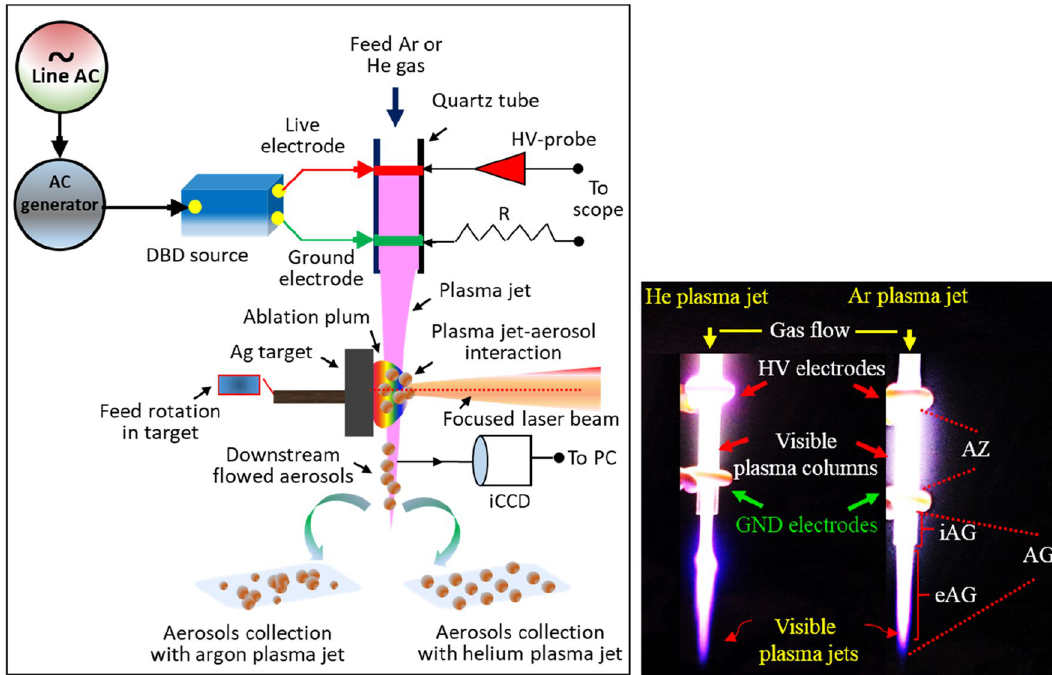
Figure 1. Experimental sketch showing a DBD plasma source, laser ablation process, post-processing & deposition of nanoparticle aerosols with the outflowing plasma jet, the HV-probe to measure the electrical signals, and iCCD to capture discharge optical images. The insets shown are two digital photographs, illustrating the physical appearance of various regions of argon and helium plasmas; the active zone (AZ) between the electrodes, and the afterglow (AG) region, starts just behind the grounded electrode and is further subdivided as the internal afterglow (iAG) inside the tube (beyond the ground electrode to the tube orifice) and the external afterglow (eAG) outside the tube which propagates as a visible